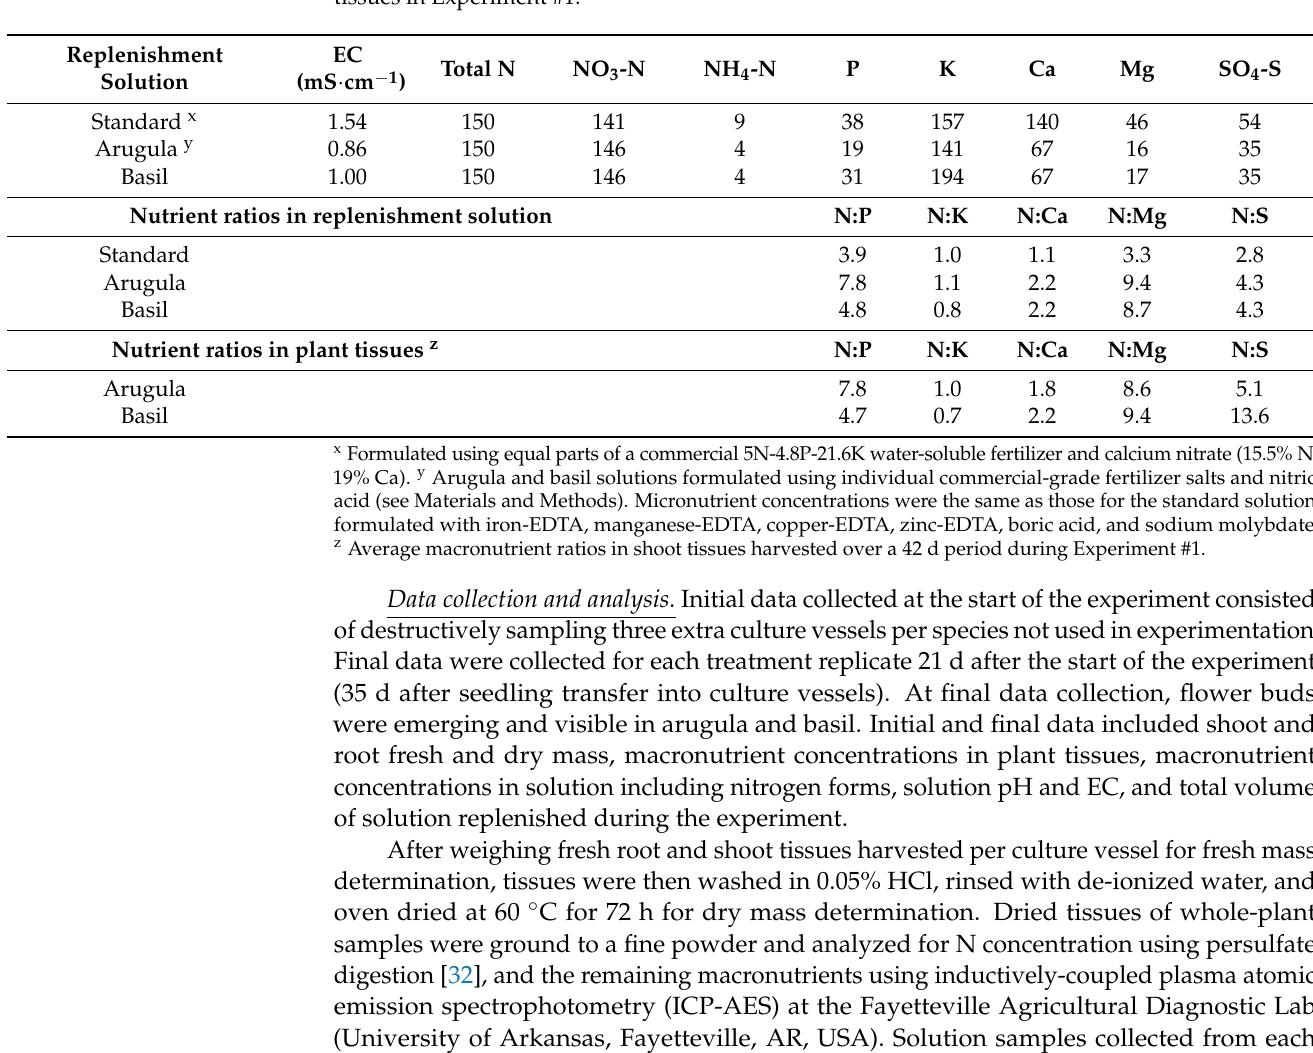
Table 2. Initial electrical conductivity (EC) and target concentrations (mg · L − 1 ) of total nitrogen (N), nitrate nitrogen (NO 3 -N), ammonium nitrogen (NH 4 -N), phosphorus (P), potassium (K), calcium (Ca), magnesium (Mg), and sulfate-sulfur (SO 4 -S) for the standardized and species-specific replenishment solution treatments for arugula and basil. Micronutrient concentrations for standard and species- specific solutions were (mg · L − 1 ) 2.28 iron, 0.34 manganese, 0.12 zinc, 0.34 boron, 0.12 copper,